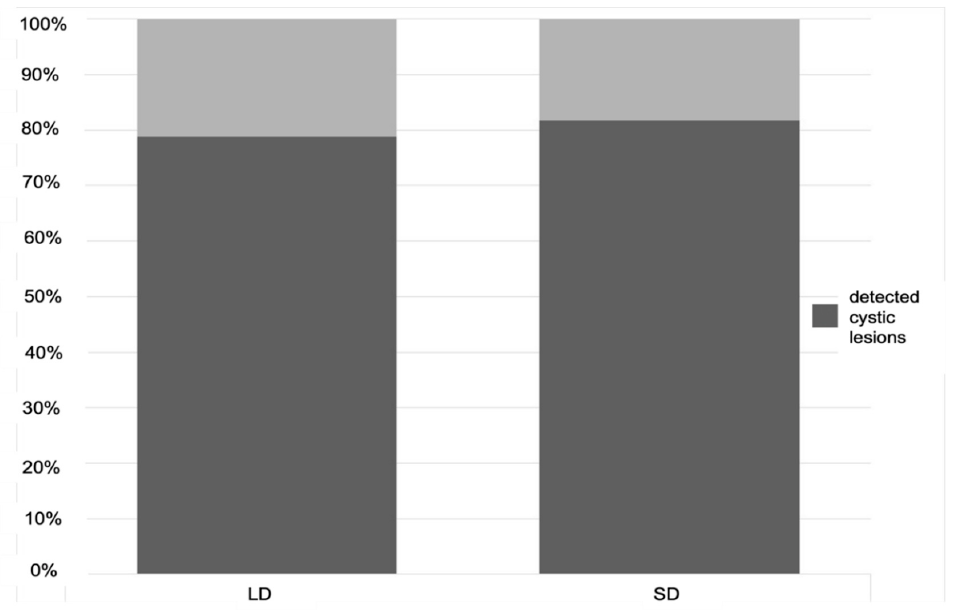
Figure 2. Detectability rates (percentage) of the cystic lesions in the low dose (LD) and standard-dose (SD) imaging protocol. The detection of cystic lesions was successful in 78.8% of cases with the low-dose protocol and in 81.6% with the standard protocol.